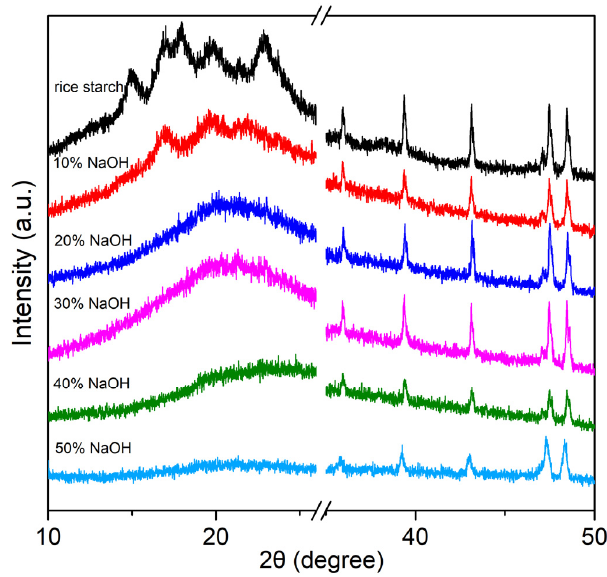
Figure 4. XRD patterns of native rice starch film and CMSr films synthesized with 10%, 20%, 30%, 40%, and 50% NaOH